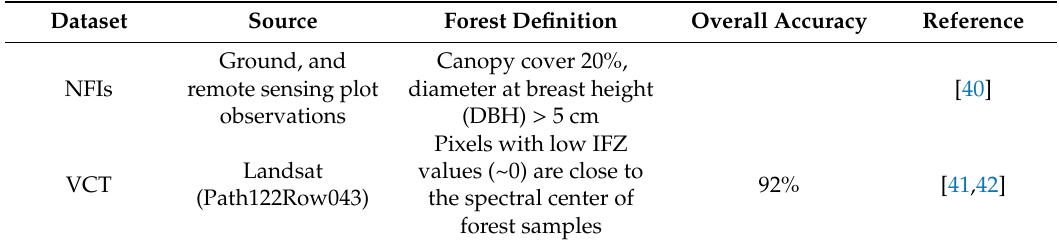
Table 2. Summary of field inventories and forest change products used for accuracy